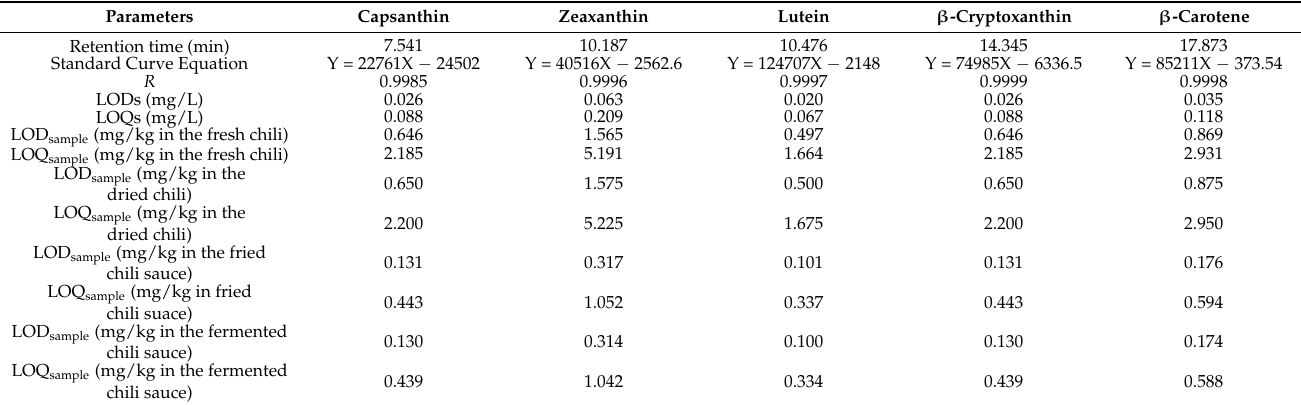
Table 1. Validation parameters of the analytical